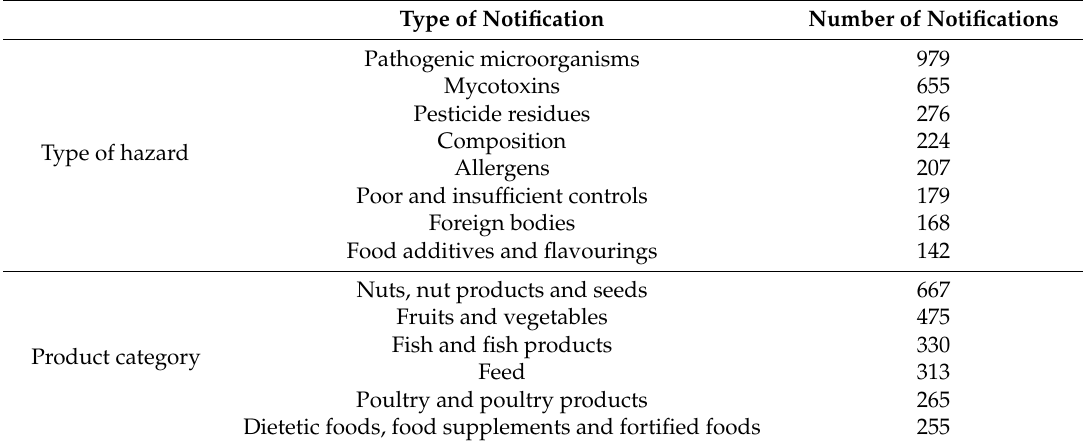
Table 1. Notifications by type of hazard and product category in 2018